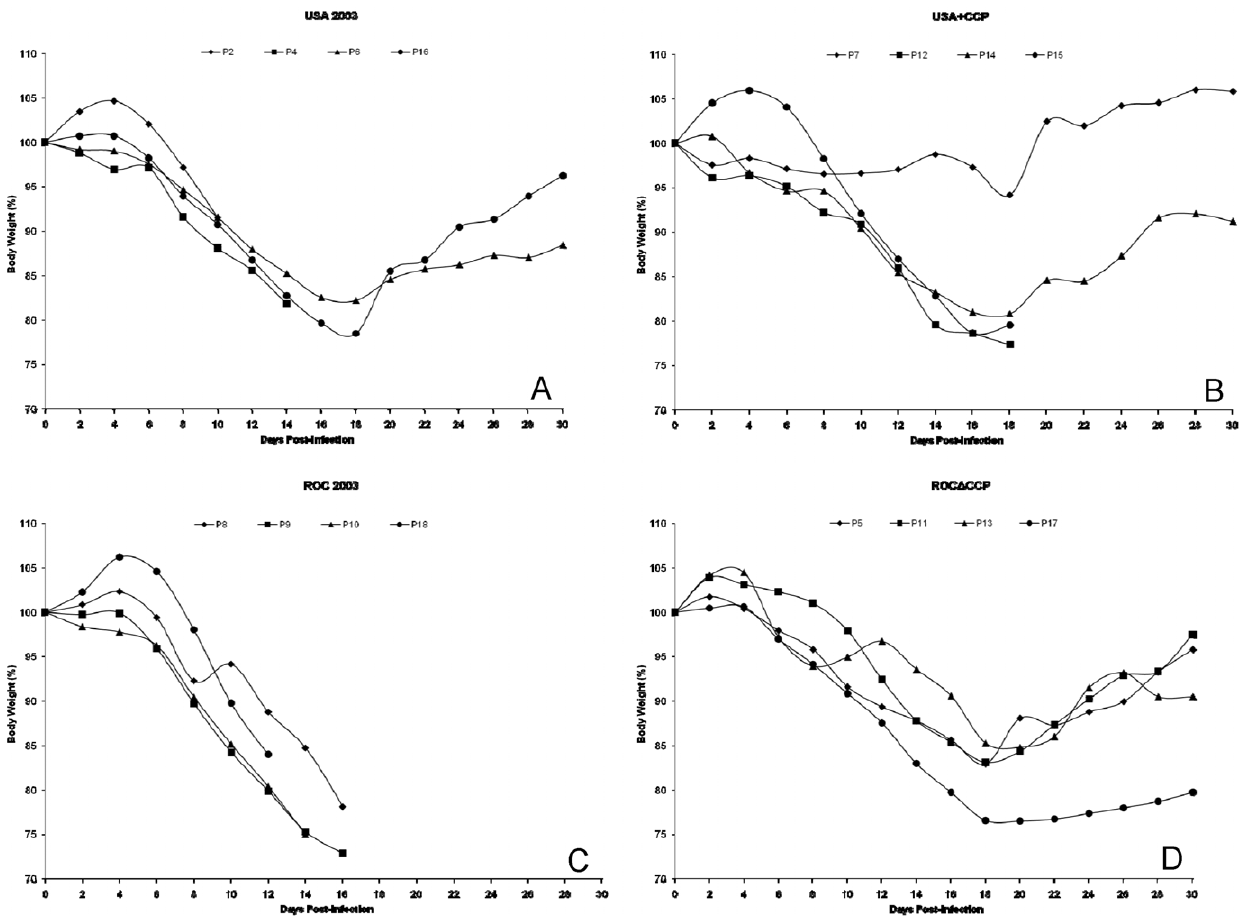
Figure 9. Prairie dog weight graphs. Percent weight loss graph for all four infection groups, USA 2003 (A), USA + CCP (B), ROC 2003 (C), and ROC D CCP (D). Each prairie dog within their respective infection group was listed with a different symbol according to legend.